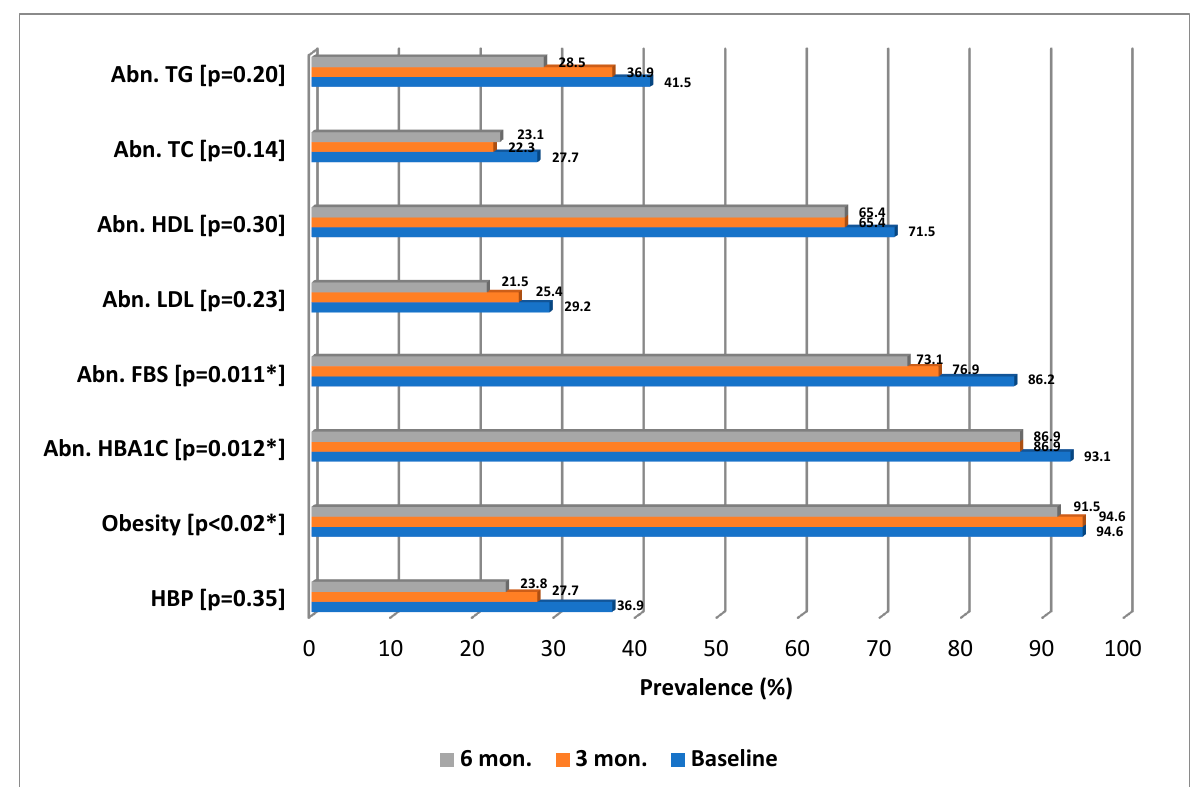
Figure 3. Prevalence of abnormal clinical and laboratory parameters before and after the educational intervention. Note: BMI—body mass index, SBP—Systolic blood pressure, DBP—diastolic blood pressure, HBP—High blood pressure, TC—Total cholesterol, LDL—low density lipoprotein,